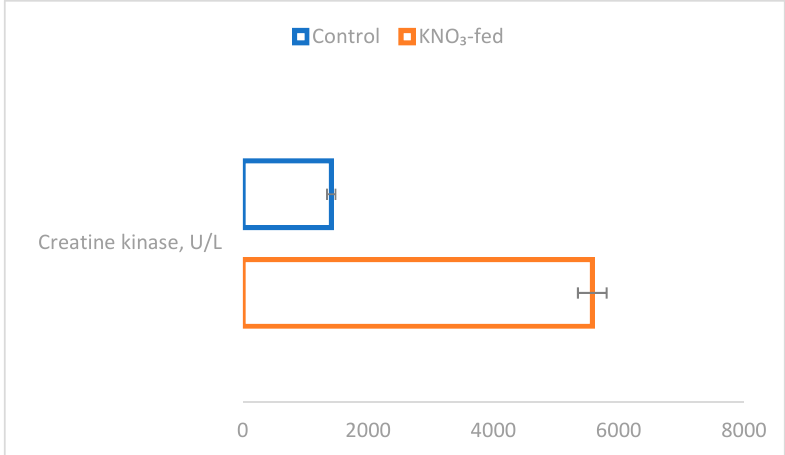
Figure 3. Creatine kinase indication.